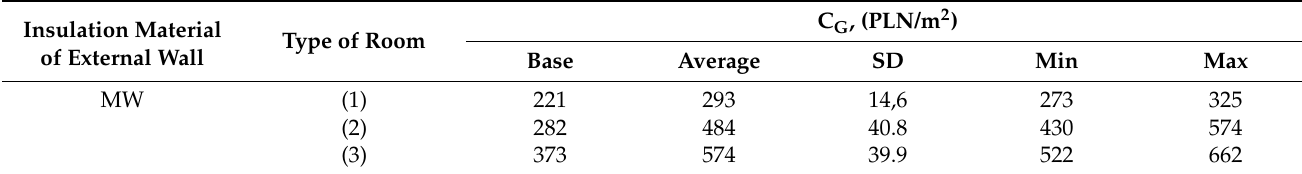
Table 7. The value of global cost for variants for the Warsaw climatic zone. Insulation Material of External